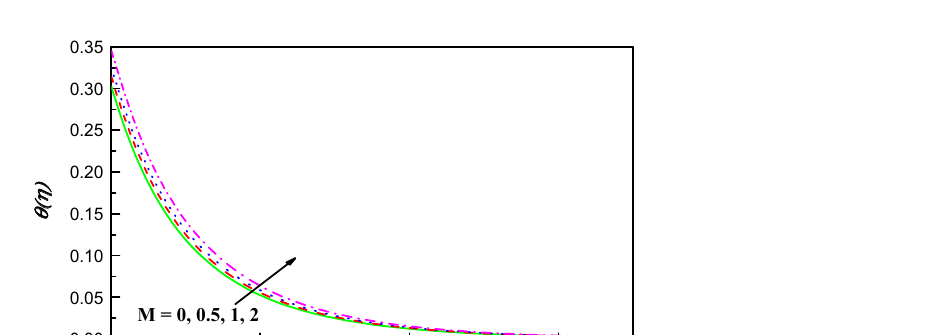
Figure 4. f ′ (η) variation vs. M .